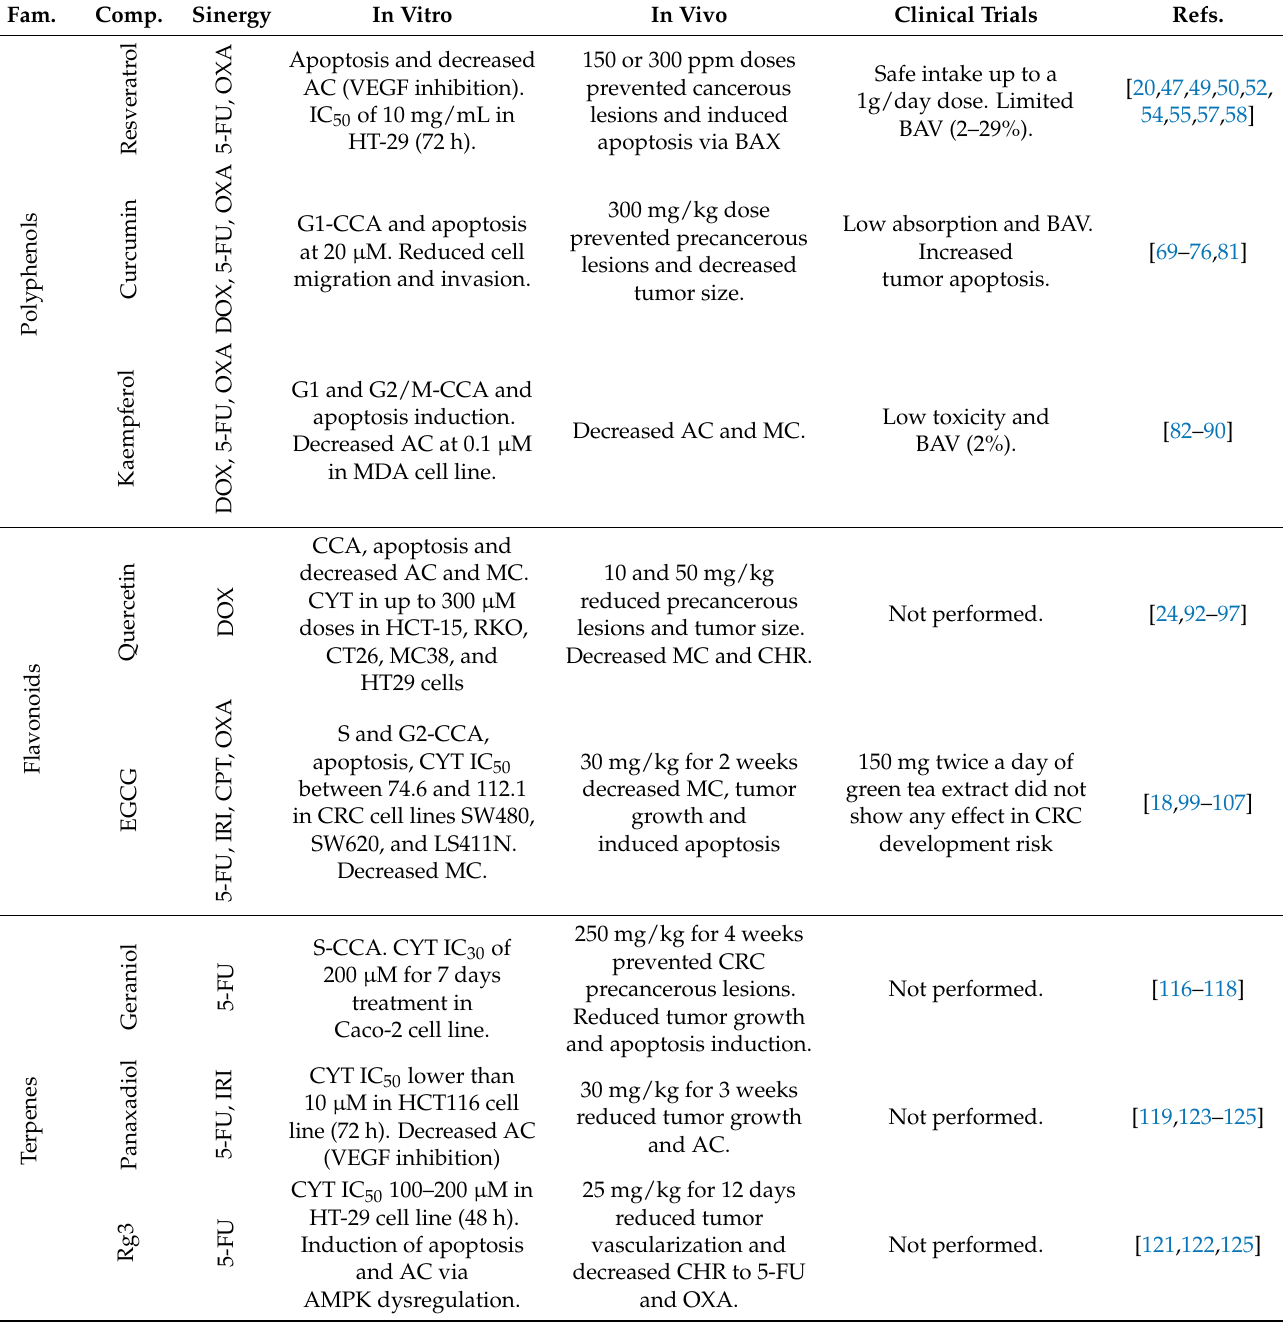
Table 1. Summary of the in vitro and in vivo effects that were exerted by the bioactive natural compounds that were analyzed.